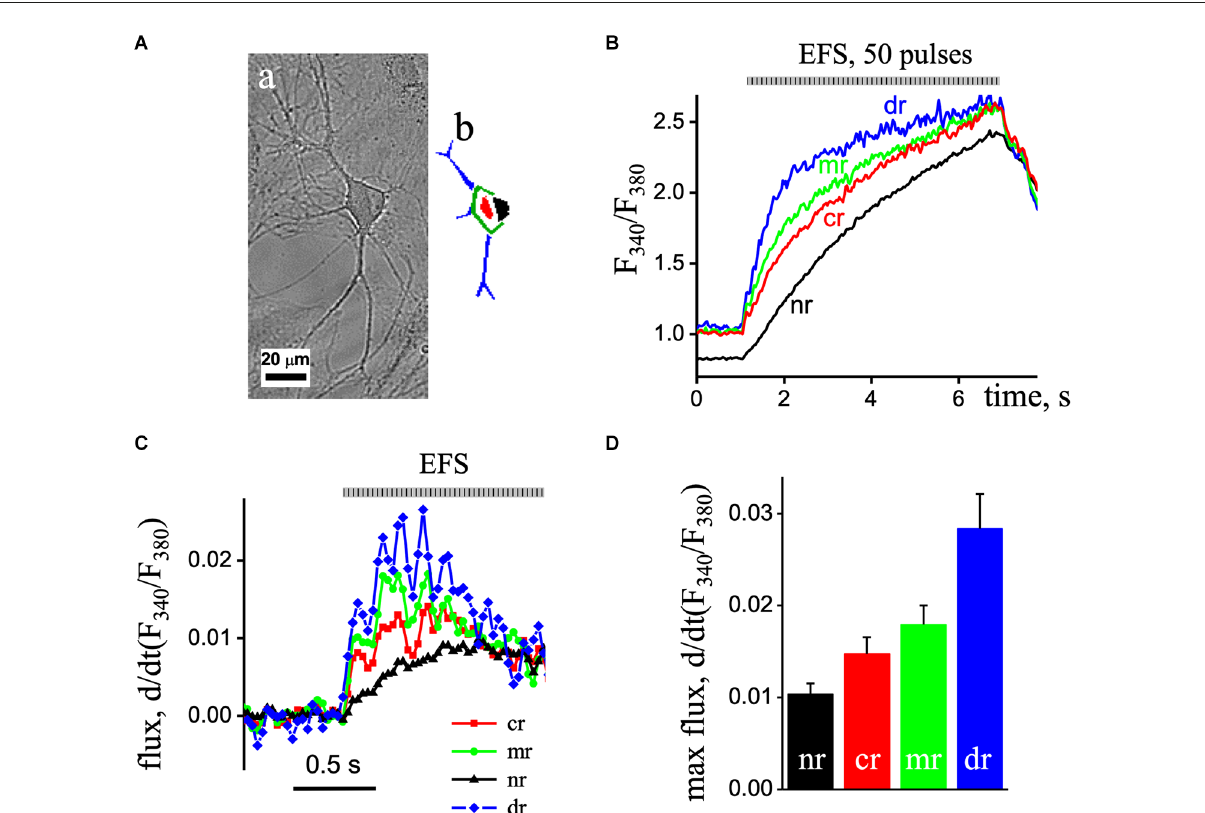
FIGURE2 Fast recording of EPS-induced Ca 2 + transients in a pyramidal-like hippocampal neuron. (Aa) The image of the cell obtained by direct illumination. (Ab) Different ROIs of the neuron are colored. (B) The imaged ratio of F340/F380 of Fura-2 loaded neuron with 50 EPS was separated as time profiles in the dendritic tree (blue line; dr), sub-membrane (green line, mr), central area (red line; cr), and nuclear (black line; nr) regions of the neuron. (C) d(F340/F380)/dt (s − 1 ), the first derivative of the ratio of the Ca 2 + signal obtained in the nuclear (black triangles line), central area (red squares line), and sub-membrane (green circles line) regions of the neuron. The flux data were derived from the data presented in part (B) . (D) Mean value of the maximal flux rate obtained in the nuclear (black bar), central area (red bar), and sub-membrane (green bar) regions of the